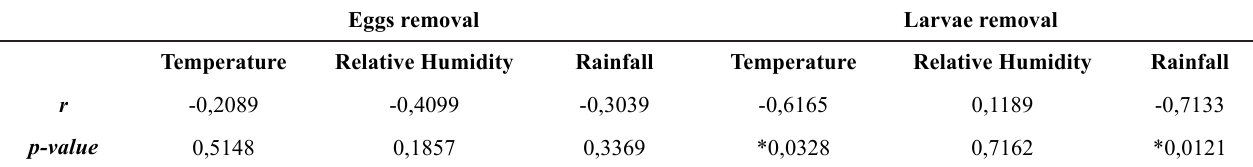
Table 2 . Spearman’s correlation coefficient (r) and p-value (* p <0.05) between the absolute frequencies of eggs and larvae removed from the cells of M. montei ’s nests in relation to average temperature (° C), relative air humidity and rainfall rate (mm) according to the four seasons (Fall, Winter, Spring and Summer).